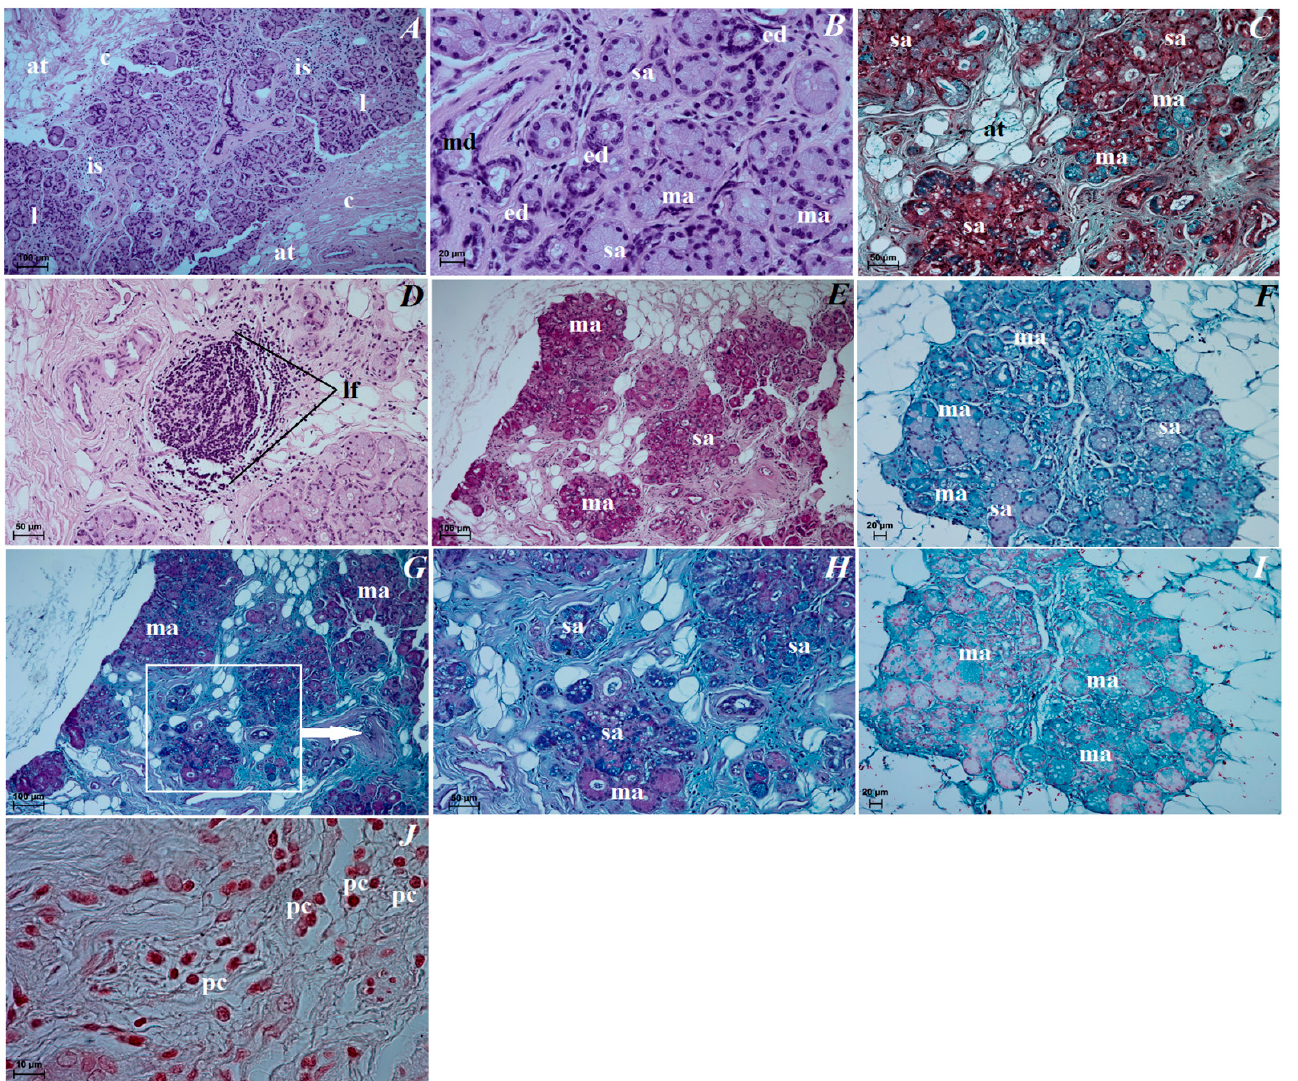
Figure 8. Photomicrograph of the Ursus thibetanus lacrimal gland. ( A , B , D ) = H&E; ( C ) = Movat pentachrome stain; ( E ) = PAS middle (++) positive reaction in the mucous acini and weakly (+) positive reaction in the serous acini; ( F ) = AB pH 2.5 middle (++) positive reaction in the mucous and negative ( − ) reaction in the serous acini; ( G , H ) = AB pH 2.5/PAS middle (++, magenta color—neutral mucins) in the mucous acini and middle (++, blue color—acidic sulfated mucosubstances and sialomucins) in the serous acini; ( I ) = HDI weakly (+) positive reaction in the mucous acini and HDI negative ( − ) reaction in the serous acini; ( J ) = MGP Y stain. at—adipose tissue,